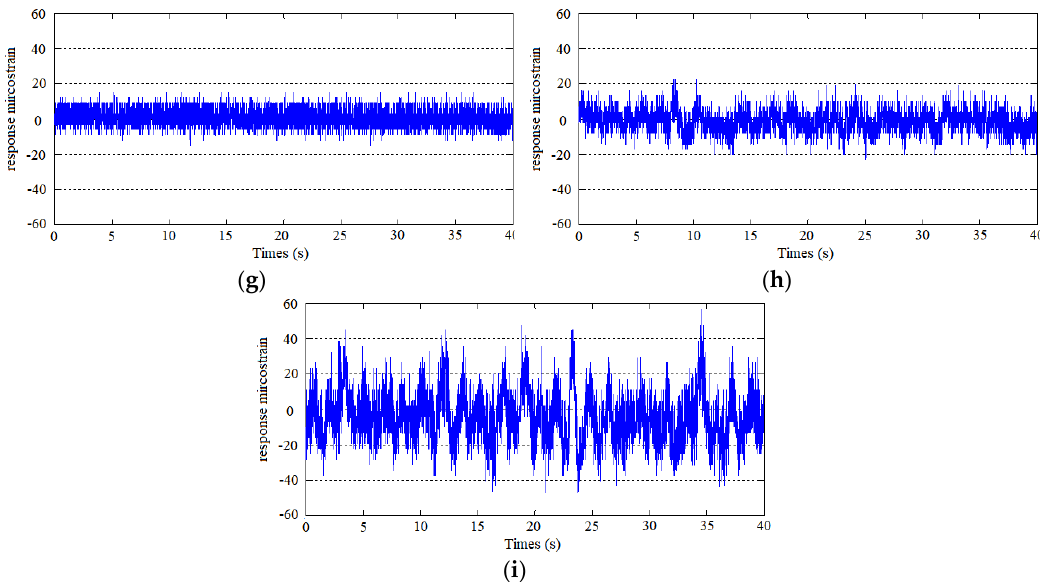
Figure 7. Response microstrain curves of the three risers at z = 0.5 m with a 65 N top tension force and the S-F end condition. ( a ) 0.2 m/s, Al, case 10; ( b ) 0.6m/s, Al, case 11; ( c ) 1.0 m/s, Al, case 12; ( d ) 0.2 m/s, PMMA, case 22; ( e ) 0.6 m/s, PMMA, case 23; ( f ) 1.0 m/s, PMMA, case 24; ( g ) 0.2 m/s, UPVC, case 34; ( h ) 0.6 m/s, UPVC, case 35.